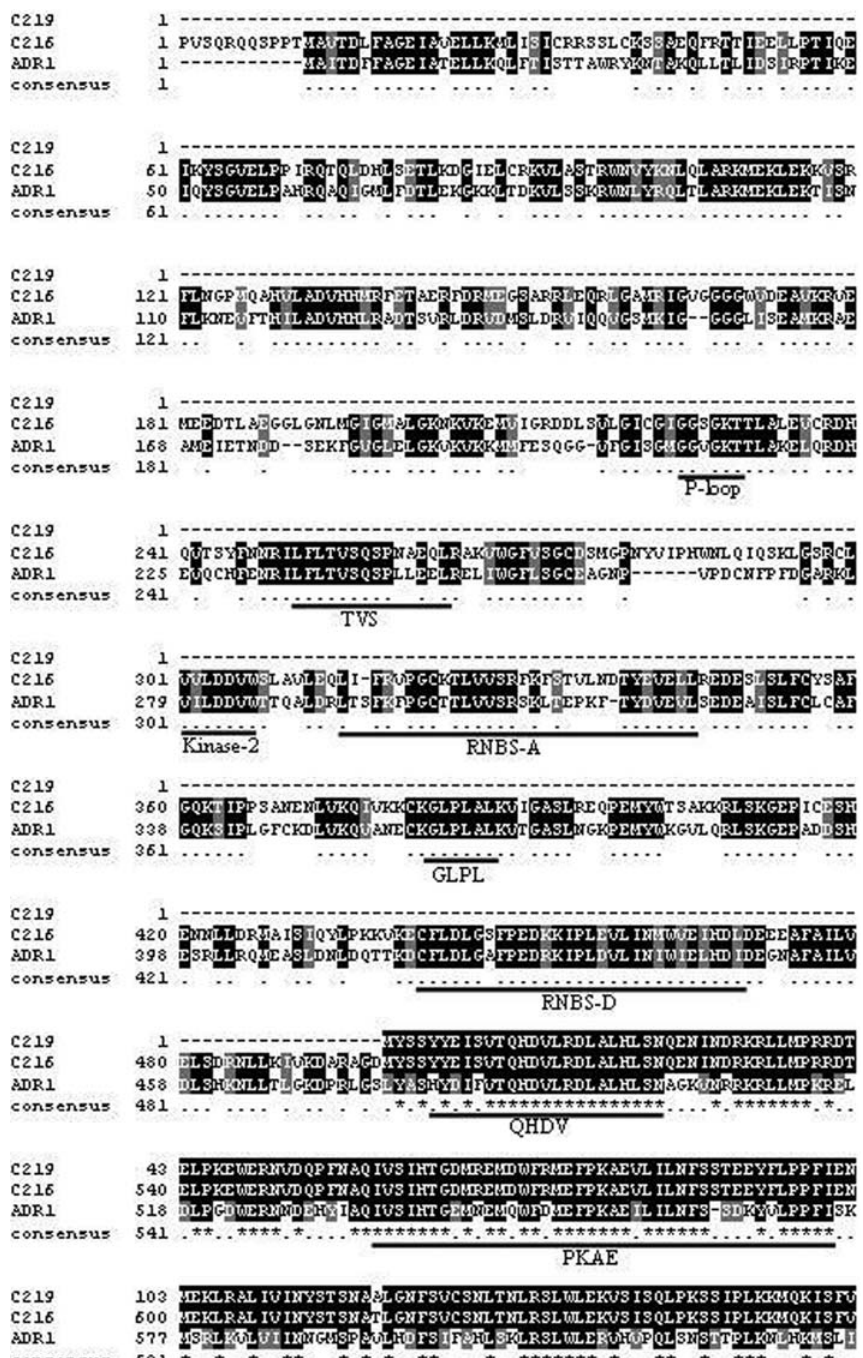
Figure 1 - Alignment (ClustalW) of the contigs C216 and C219 and Arabidopsis ADR1 (GenBank Accession Number NP_195056). Amino acids boxed in black and (*) are invariant, whereas residues shaded in gray and (.) are conserved in > 75% of the sequences. The motifs of the NBS domain (P-loop, kinase2, RNBS-A, GLPL, RNBS-D, QHDV, TVS and PKAE) are